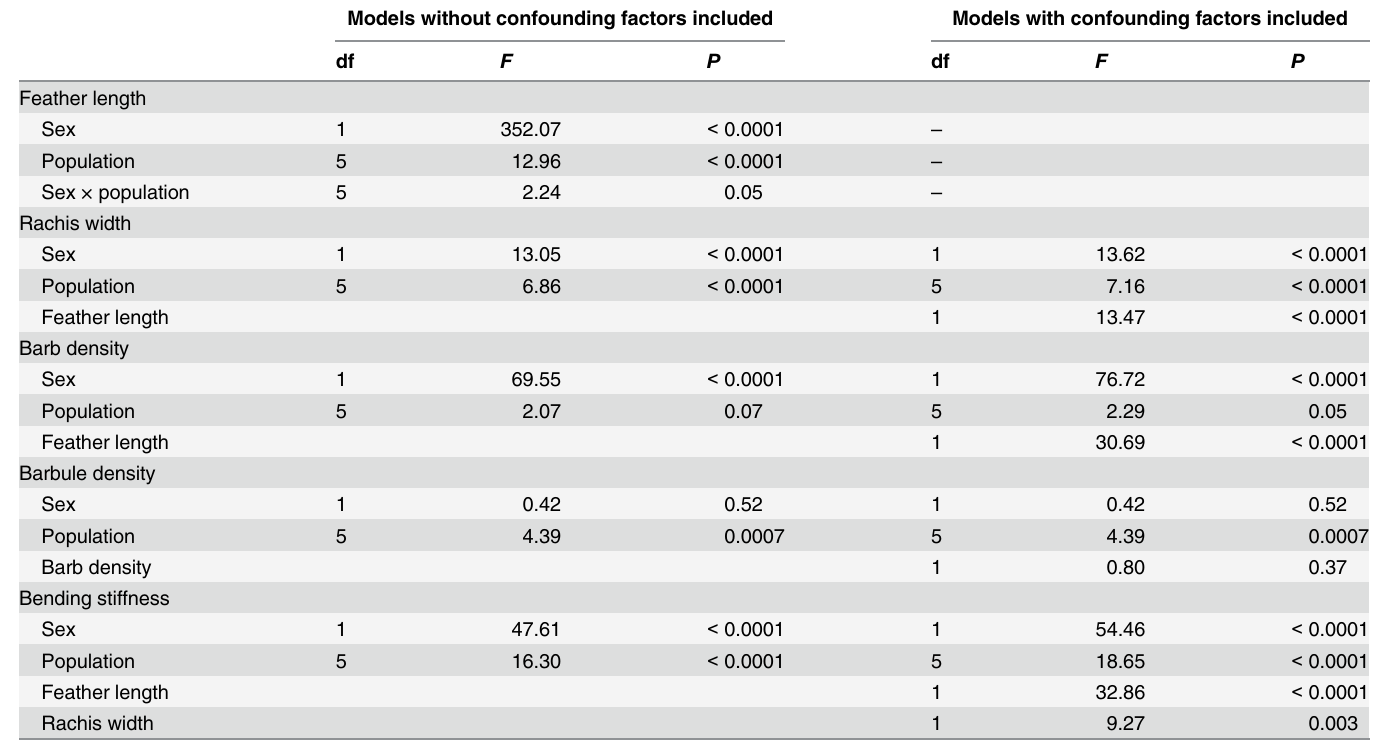
Table 3. Linear models of the population and sex differences in quality traits and growth of the outermost tail feather (Ta6) of barn swallows. Models without confounding factors included Models with confounding factors